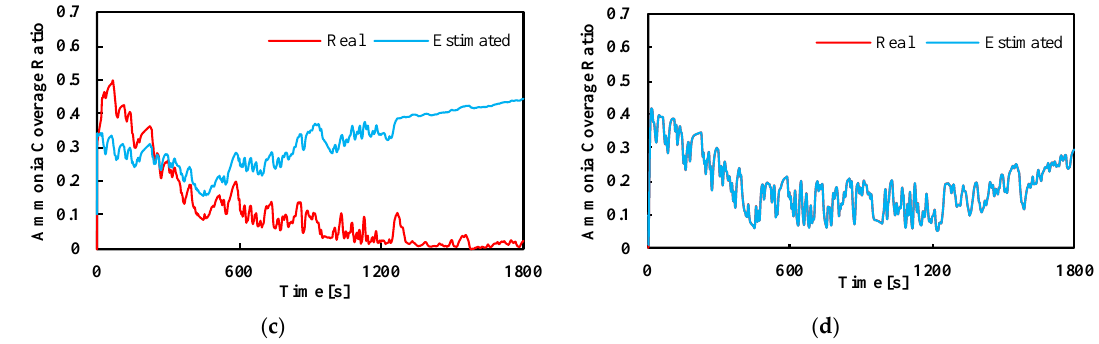
Figure 11. Ammonia coverage ratio vs. time. ( a ) Stuck fault; ( b ) gain fault; ( c ) drift fault; and ( d ) normal.